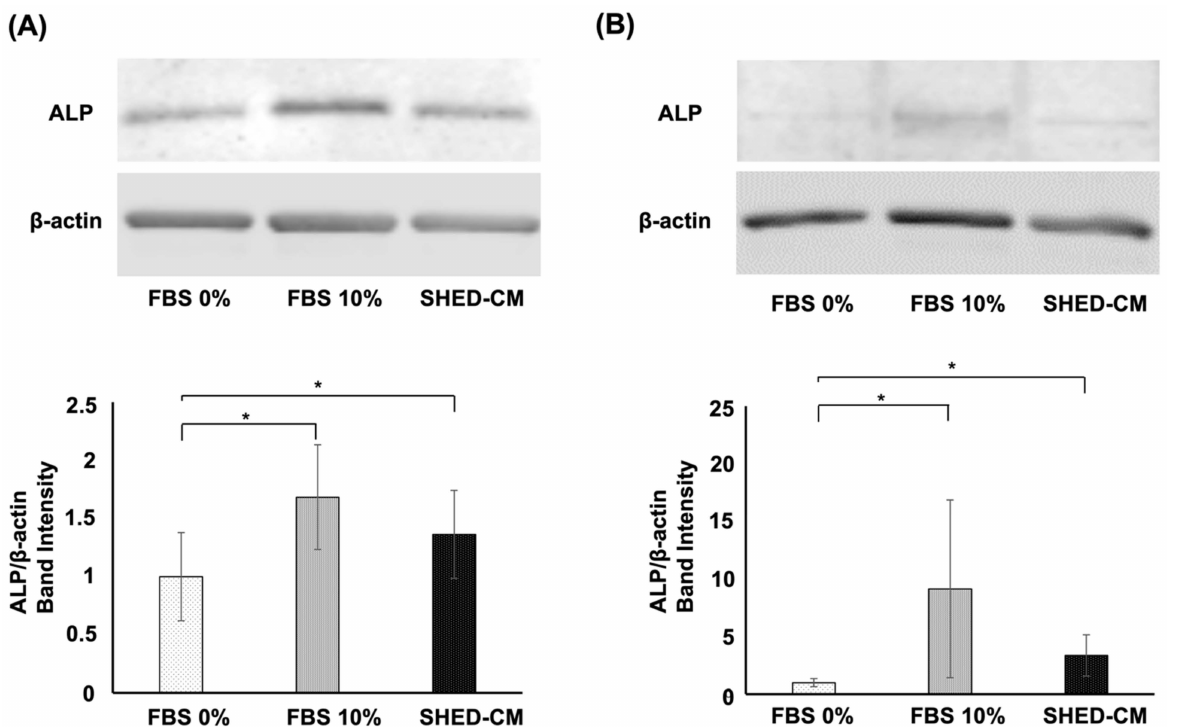
Figure 5. Effects of SHED-CM on ALP protein expression in hBMSC and MC3T3-E1 cells. ALP protein levels were enhanced by exposure to SHED-CM or 10% FBS in ( A ) hBMSCs and ( B ) MC3T3- E1 cells, compared with the 0% FBS group. β -actin expression was used as a loading control. ( n = 3; * p < 0.05) SHED-CM, human deciduous dental pulp-derived mesenchymal stem cell-derived culture